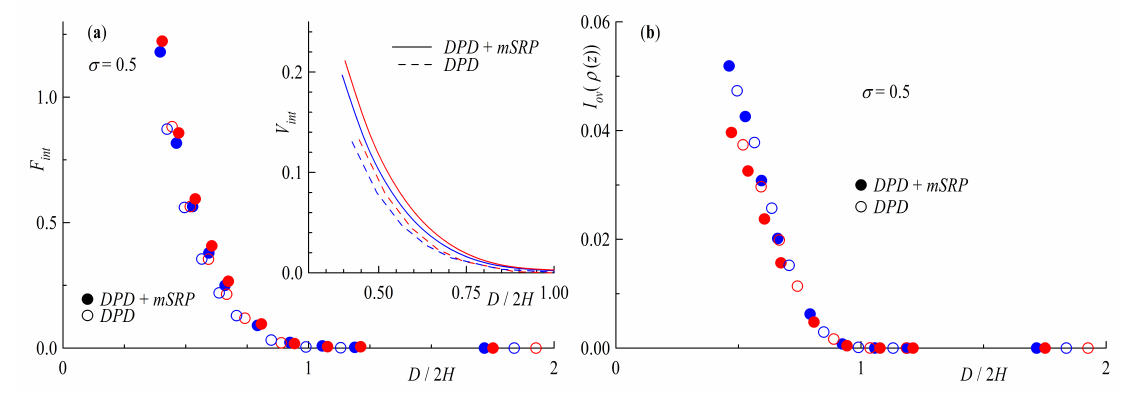
(cid:82) 0 ( z ) zd d z · ( − 1 ) generated by polymer beads acting on the Figure 11. ( a ) Interaction force F int = − ∞ ρ (cid:82) F int . ( b ) Integral of overlap walls of the system. The insert depicts the interaction potential V int = (cid:82) D I ov ( ρ ( z )) = ρ 1 ( z ) ρ 2 ( z ) d z . Both plots are shown as a function of brush distance D scaled by two 0 times the brush height at infinite separation H at a surface coverage of σ = 0.5. Red symbols are rings with N R = 64 and blue for tails N L =